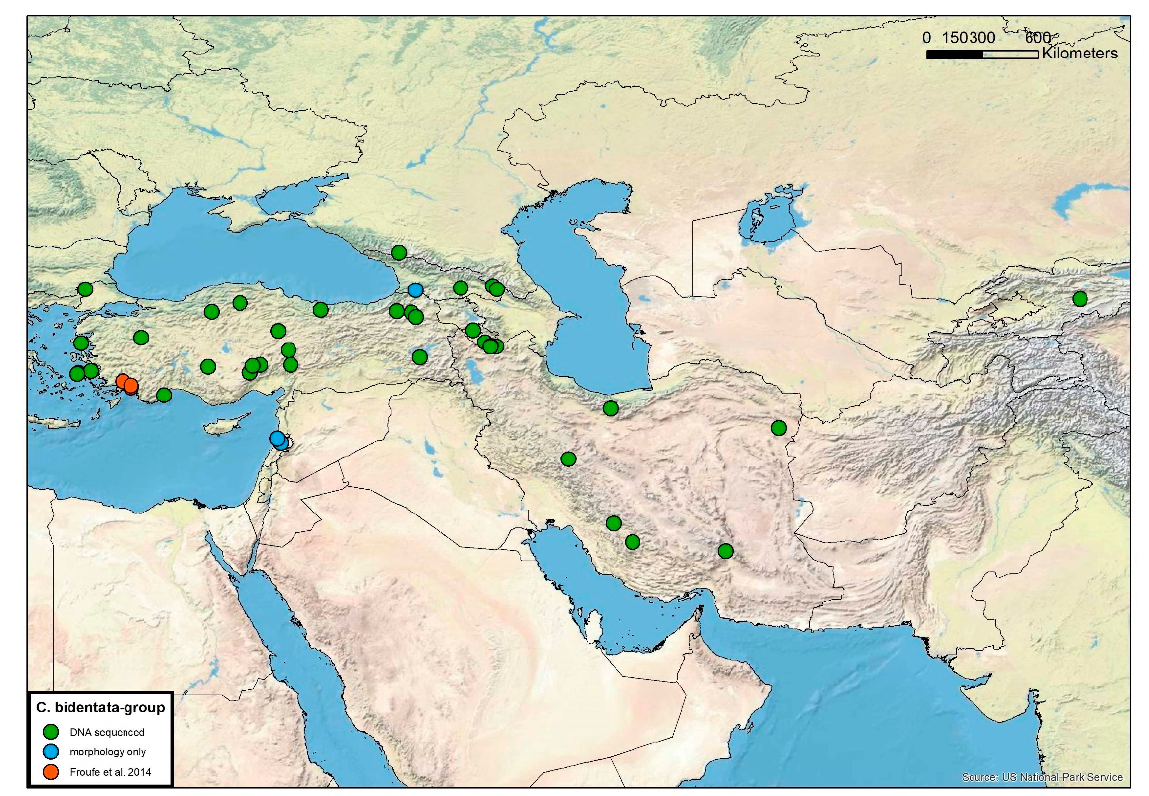
Figure 2. Map showing the origin of the investigated specimens of the C. bidentata -group.